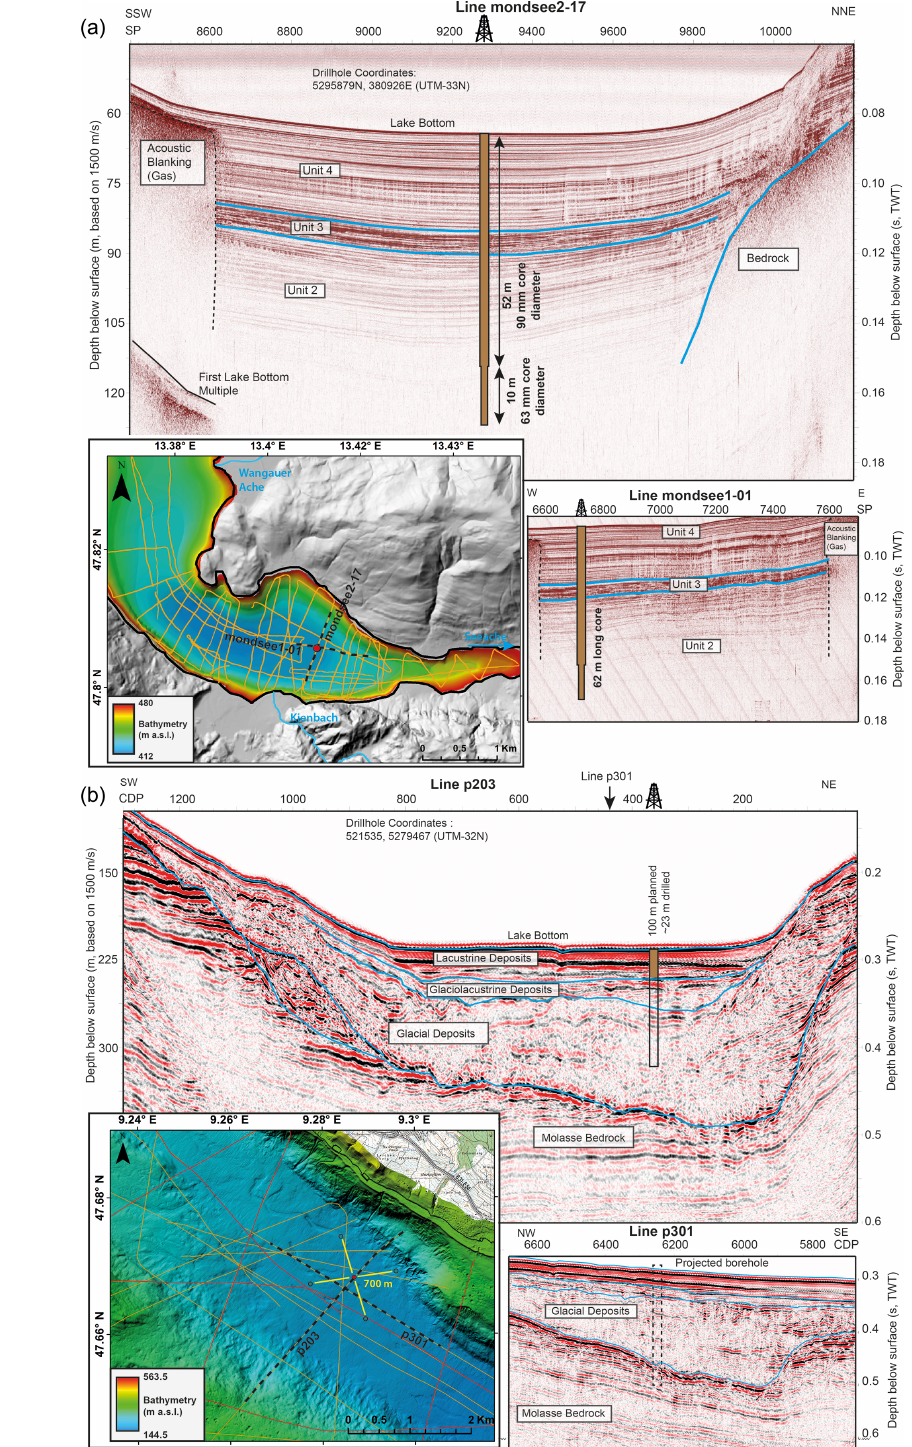
Figure 6. Lakes Mondsee and Constance site survey data and coring sites. (a) Bathymetric overview of Mondsee (Austria; data courtesy of Immo Trinks), with the digital elevation model superimposed. Largest (dis-)tributaries are outlined. Orange lines indicate the 3.5kHz high-resolution single channel seismic tracks. The extent of the seismic profiles is shown as dotted black lines. Seismic interpretation follows Daxer et al. (2018), where all details can be found. (b) Bathymetric overview of Lake Constance, east of Hagnau, with multichannel reflection seismic lines superimposed, recorded in 2016 (red) and in 2017 (orange), using two chamber Mini GI and GI 210 air guns, respectively (unpublished data). Drilling location is given as a red dot, anchor locations are in green, and the seismic stratigraphic horizons are blue lines in Lines p201 and p301, respectively (including borehole locations). The extent of the seismic profiles is shown as a dotted black